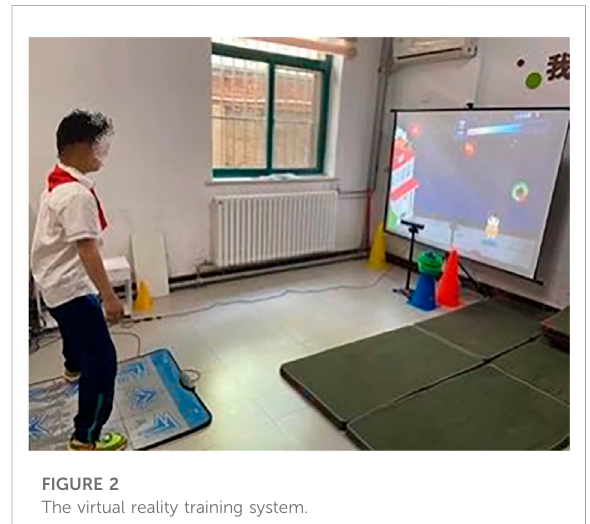
FIGURE 2 The virtual reality training